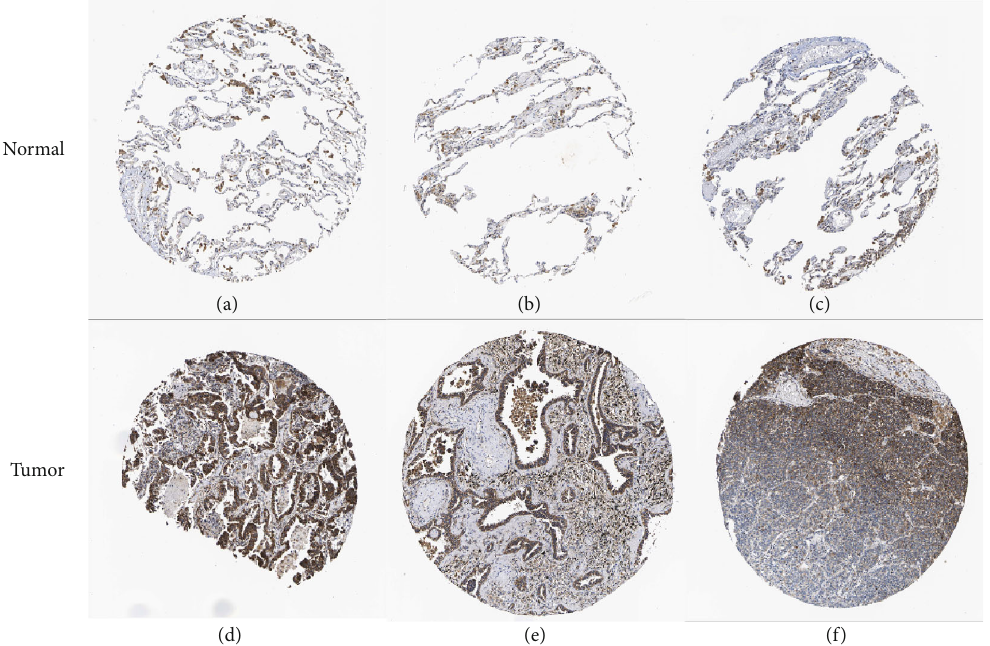
Figure 6: Immunohistochemistry (IHC) of SHMT2 expression in LUAD tissues and corresponding normal tissues based on The Human Protein Atlas (HPA). (a – c) Normal lung (T-28000) tissue and (d – f) lung (T-28000) tumor